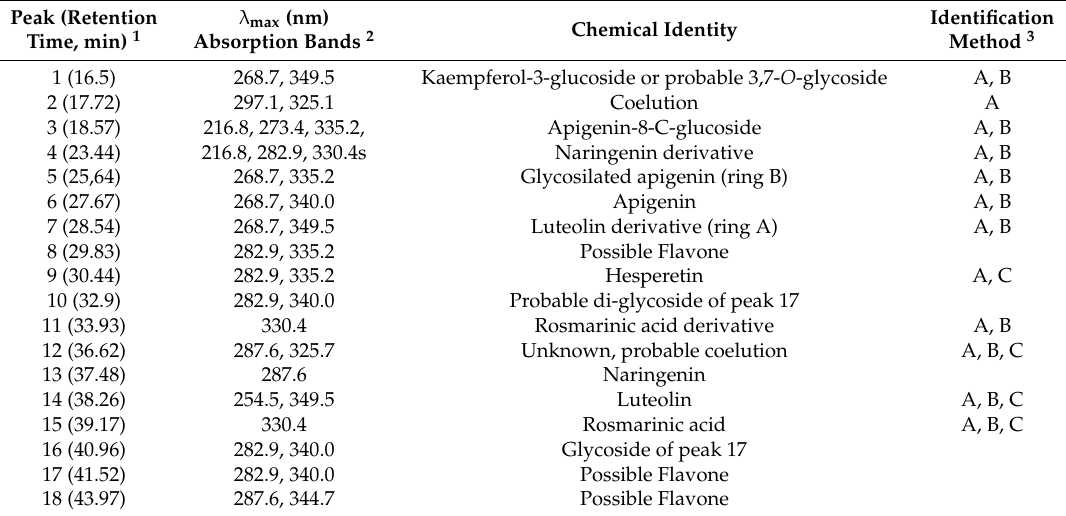
Table 5. Chemical identification of peaks obtained by HPLC-PDA in thyme